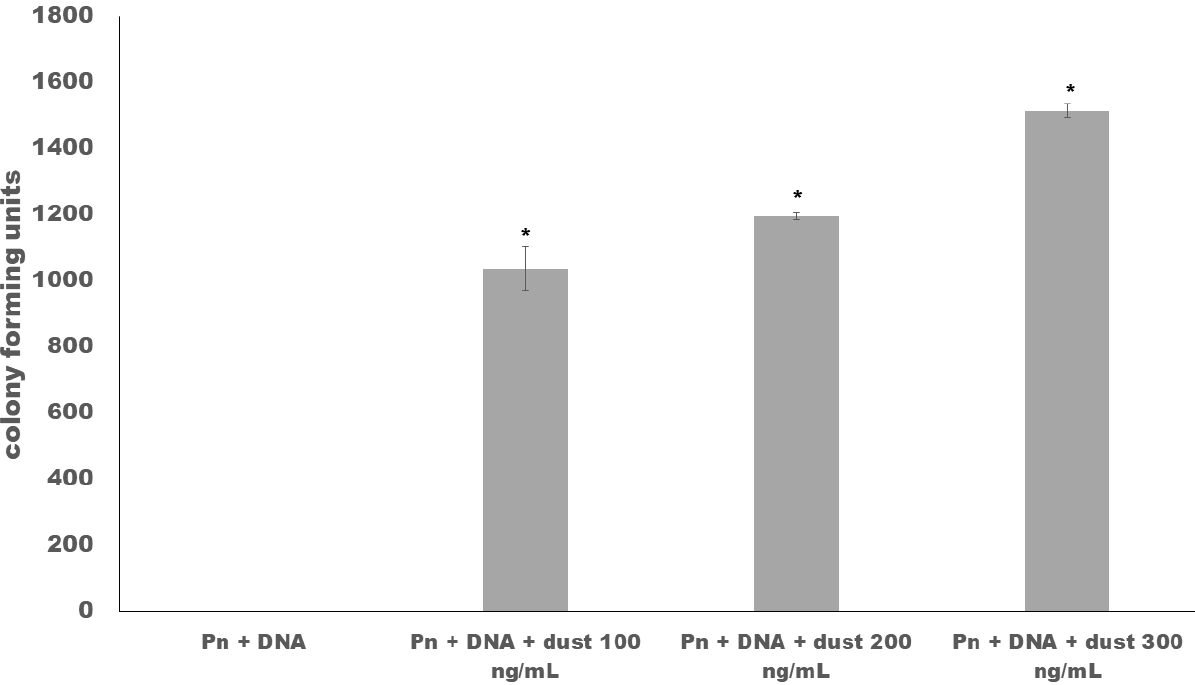
Figure 2 – Effect of different ashes concentration in pneumococci transformation. The S. pneumoniae PN360 ATCC33400 was exposed to 100, 200 and 300 ng/mL of ashes obtained from burnt sugar cane. The results showed the colony forming units obtained in triplicate tests performed similarly to protocols using nanoparticles. The increases of the colony forming units obtained from ashes use were superior than compared with control test. *All the values showed significant results when compared with control sample (p values